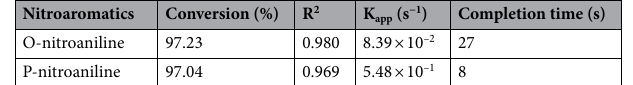
Table 2. Outcomes of o-NA and p-NA reduction using magnetic